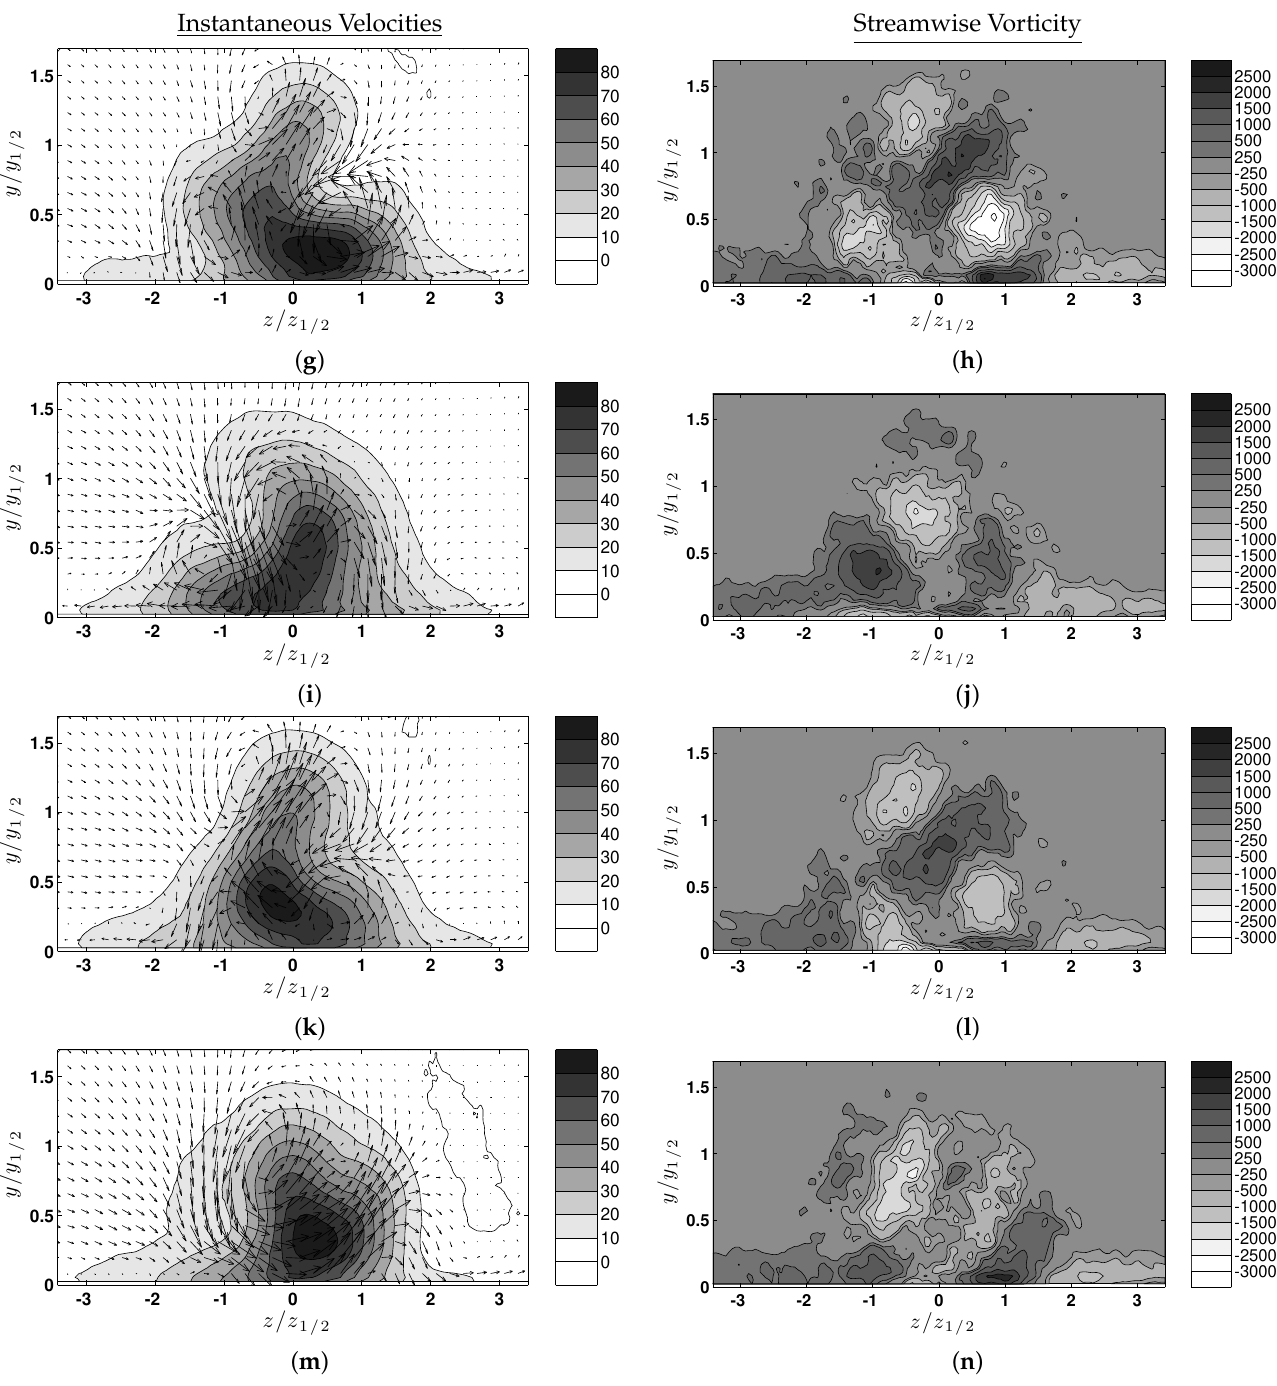
Figure 6. POD reconstruction of the instantaneous velocity ( m / s ) using the first 10 modes and the reconstructed instanta- neous streamwise vorticity ( 1/ s ) at x / D = 10. The mean streamwise velocity (normalized) and mean streamwise vorticity are shown in the first